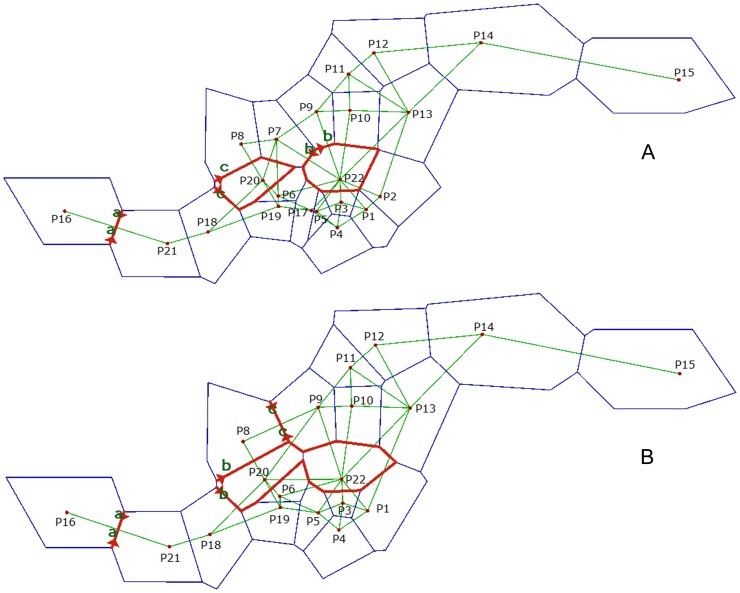
Genetic barriers predicted by BARRIER (version 2.2).The genetic barriers are shown in bold lines with arrows. A: genetic barrier predication using all populations; B: genetic barrier predication using all wild populations.